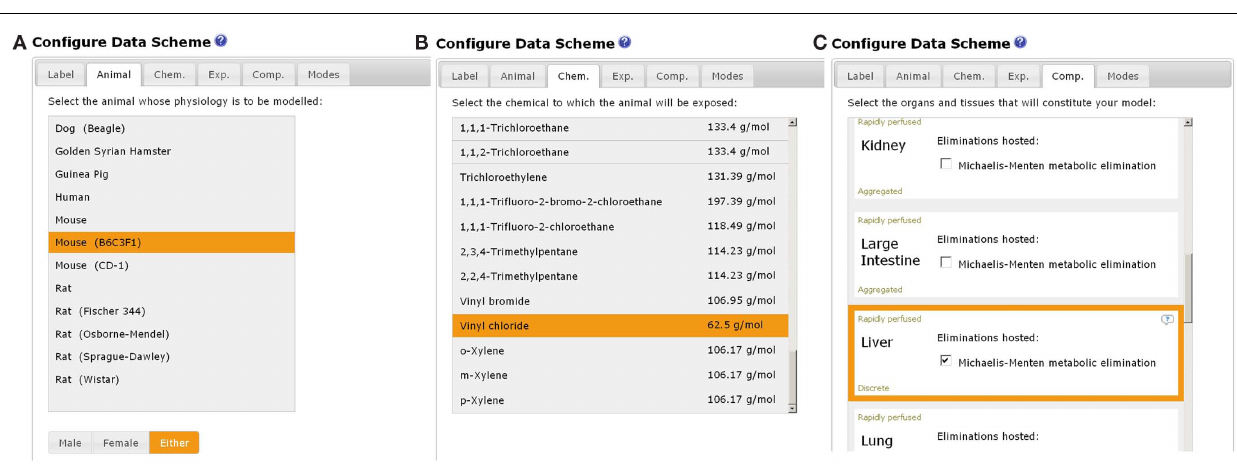
value may be calculated using an allometric equation or a user defined value applied directly within the model. If a datum